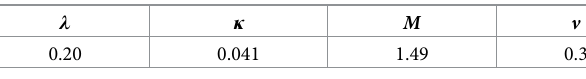
Table 2. Model parameters of Shanghai soft clay [38].